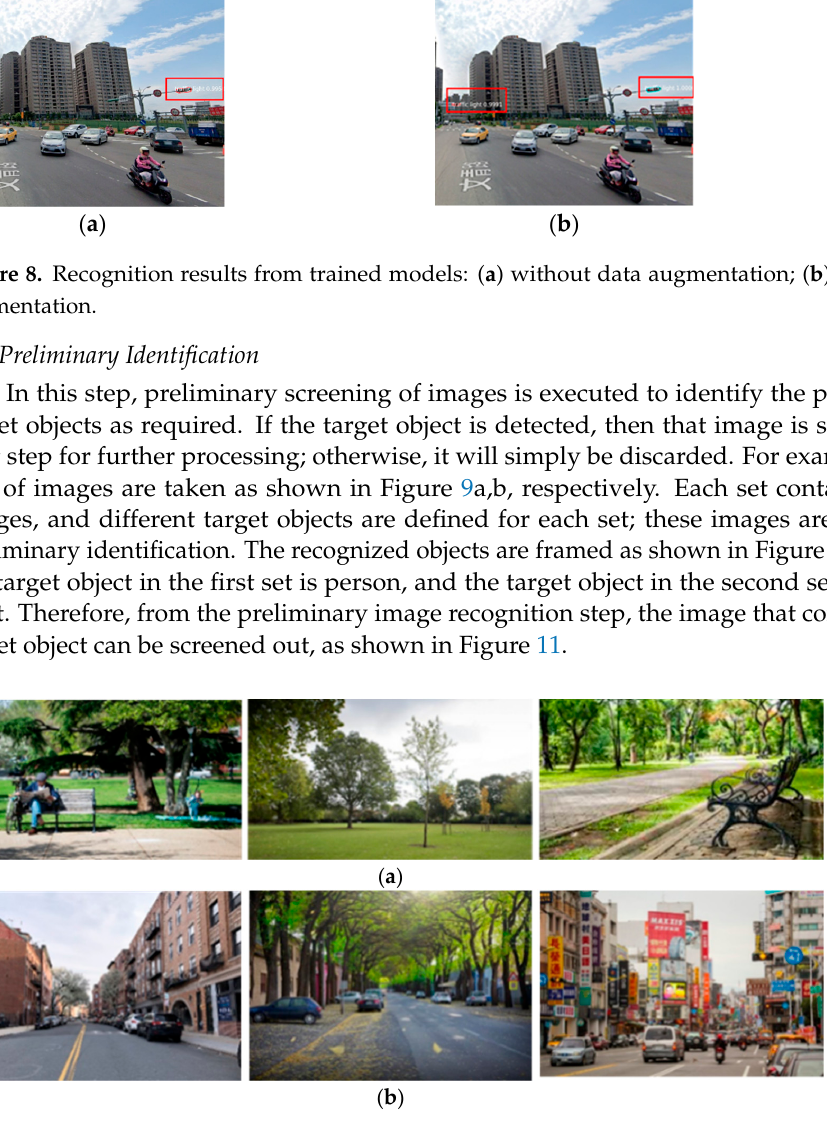
Figure 9. ( a ) First set of images ; ( b ) second set of images.